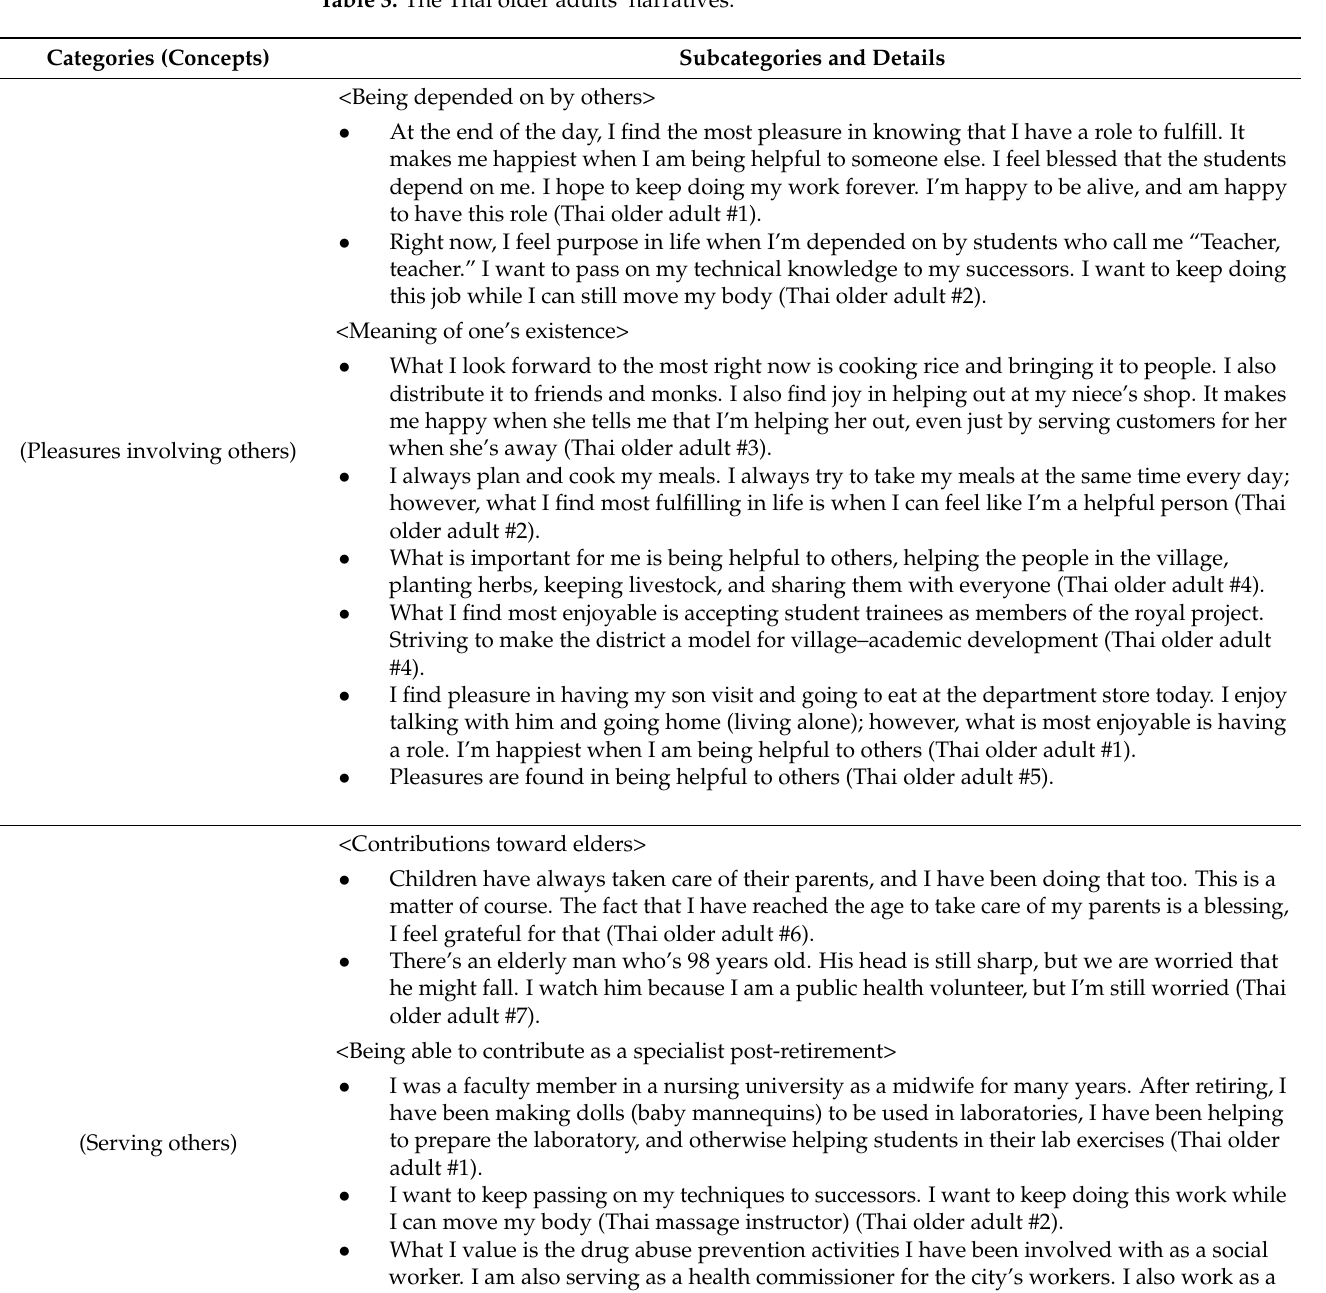
Table 3. The Thai older adults’